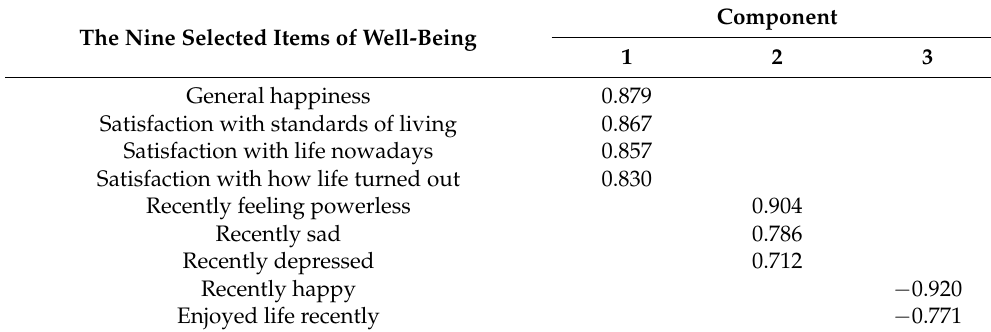
Table 3. Pattern matrix of three-component PCA solution with oblique rotation of the nine selected well-being measures. Component The Nine Selected Items of Well-Being 1 2 3 General happiness 0.879 Satisfaction with standards of living 0.867 Satisfaction with life nowadays 0.857 Satisfaction with how life turned out 0.830 Recently feeling powerless 0.904 Recently sad 0.786 Recently depressed 0.712 Recently happy − 0.920 Enjoyed life recently − 0.771